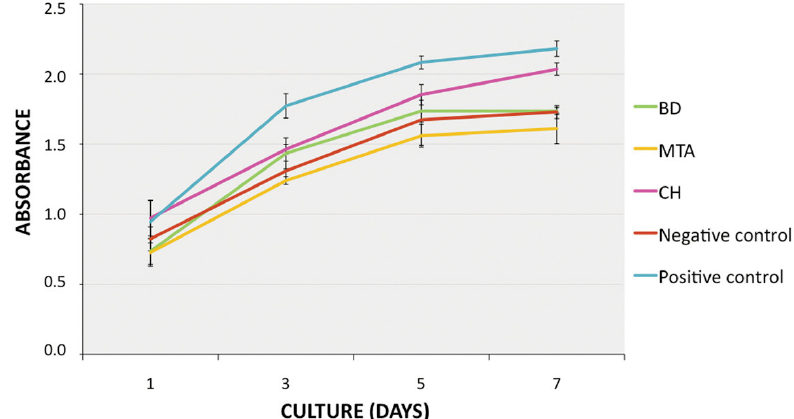
Figure 2- Effect of calcium hydroxide (CH), mineral trioxide aggregate (MTA) or Biodentine TM (BD) conditioned medium on the proliferation of stem cells from exfoliated deciduous teeth (SHED). Cells were incubated with conditioned media (1 mg/mL) for 7 days, at 37°C, and then subjected to the SRB assay. Regular growth medium (alpha-MEM with 10% FBS) or medium with 20% FBS were used as negative and positive control, respectively. Data represent mean ± SD (n=3 independent experiments, performed in triplicates)